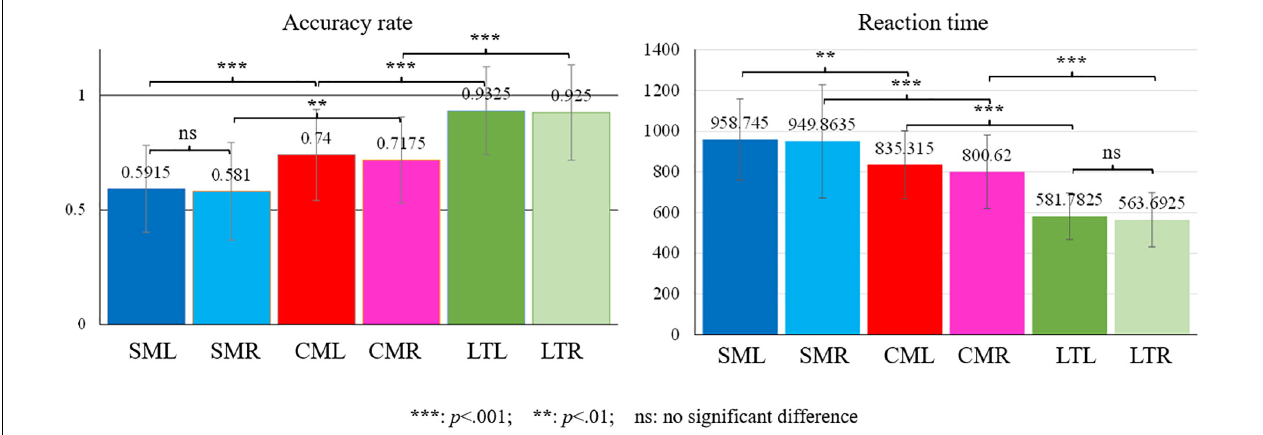
FIGURE 2 | Behavioral results. (The third letter after stimulus type refers to the visual field. For example, SML refers to scientific metaphors presented to left visual field).